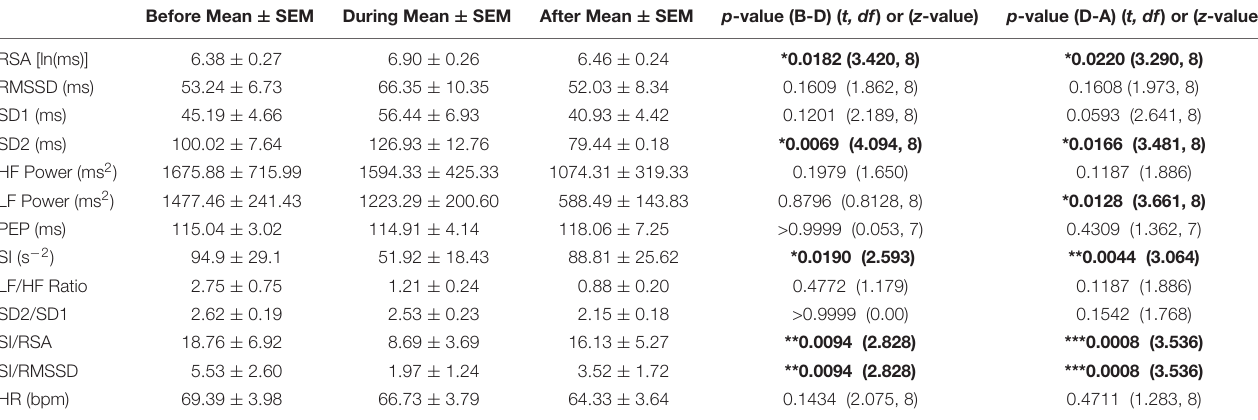
FIGURE 1 | HRV parameters associated with a single HAPW. (A) 2-min before, during, and 2-min after HAPW recorded by HRCM. (B) HF power/RSA band of HRV signal time matched with HRCM recording. (C) RMSSD time matched with HRCM. (D) SI time matched with HRCM. Distance at 0 cm is positioned at the proximal colon, distance at 80 cm is just proximal to the anal sphincter. TABLE 2 | Autonomic nervous system modulation in association with all individual HAPWs and HAPW-SPWs